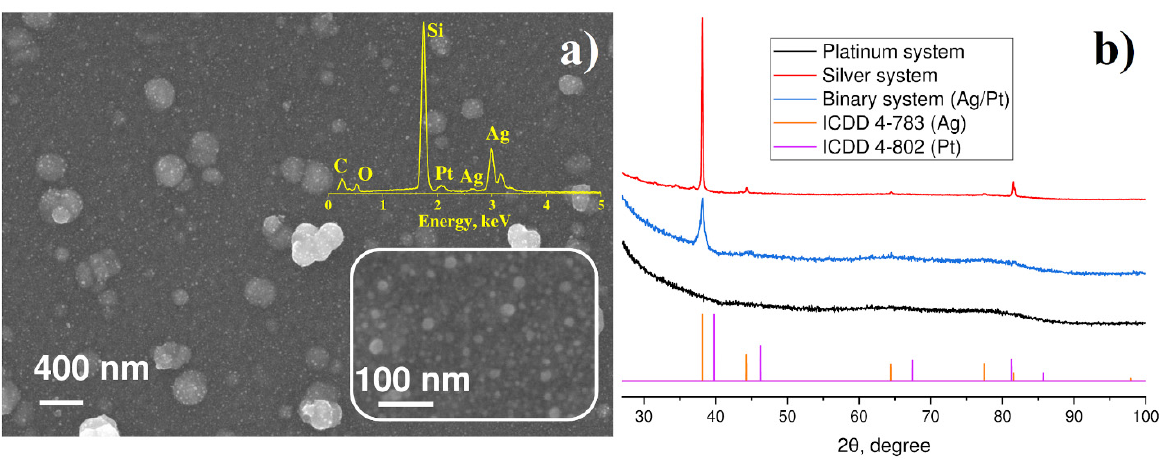
Figure 4. ( a ) SEM/EDX analysis of the of particles synthesized from mixed Pt-Ag precursors, ( b ) X-ray diffraction of particles on quartz substrates for platinum system C 8 H 18 OPtSi 2 ; silver system (C 6 H 5 COOAg in acetonitrile); binary system (C 8 H 18 OPtSi 2 + C 6 H 5 COOAg in acetonitrile); ICDD PDF-2 for platinum (4-802 card) and silver (4-783 card).